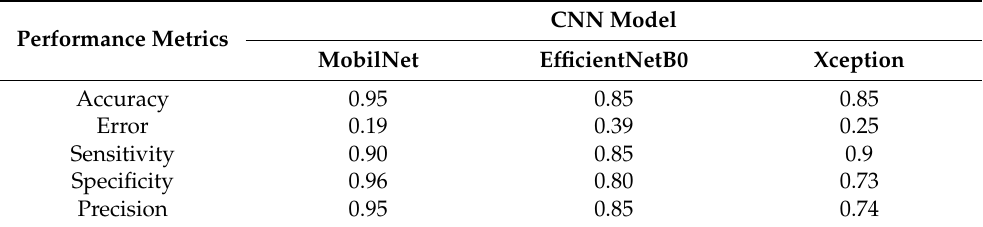
Table 4. Performance metrics of the neural network for gait pattern discrimination.